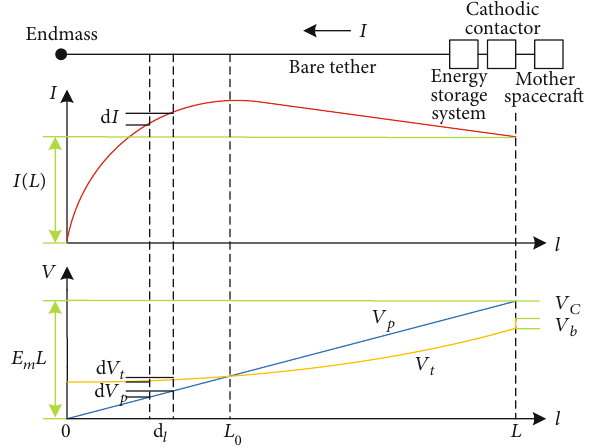
Figure 4: Potential and current distribution of a tether system.